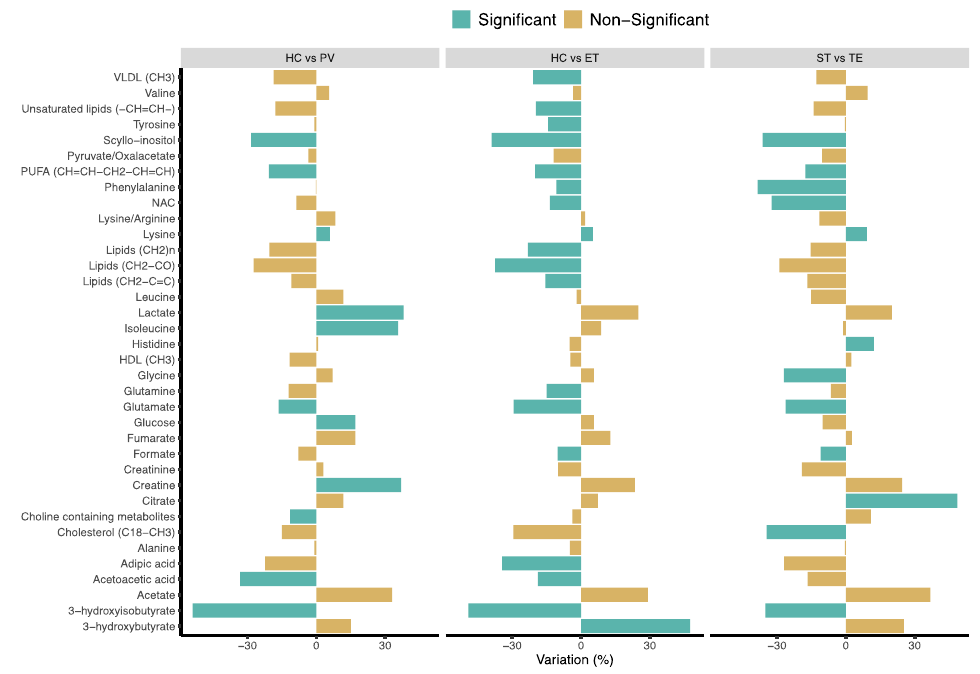
Figure 2. Variations in the level of the 36 metabolites identified by NMR in serum samples. The direction of the variation, considering the HC or ST groups as a reference. p -value calculated using the Mann–Whitney U test ( p < 0.05 was considered significant). HC: healthy control, PV: polycythemia vera, ET: essential thrombocythemia, ST: secondary thrombocythemia. HDL: high-density lipoproteins, NAC: acetyl signals from glycoproteins, PUFAs: polyunsaturated fatty acids, VLDL: very-low-density